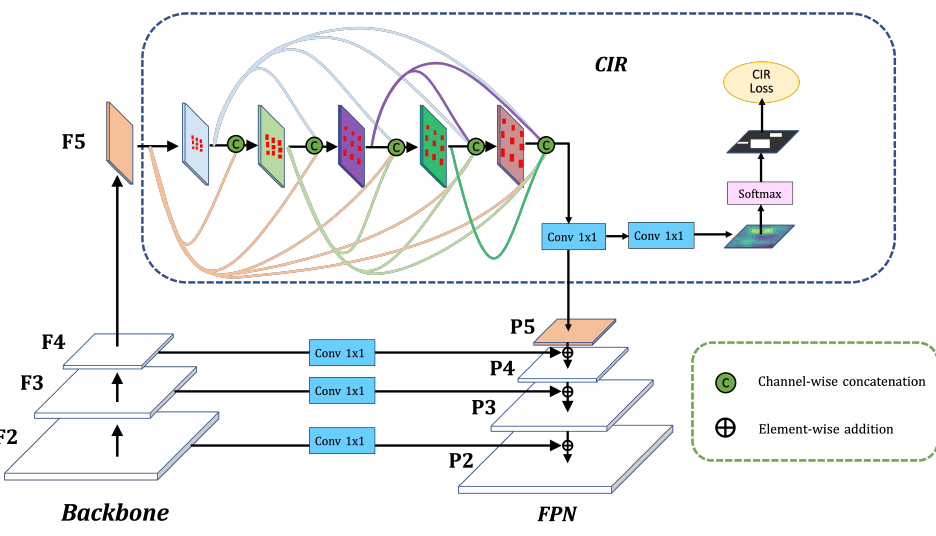
Figure 2. The diagram of the context information refinement